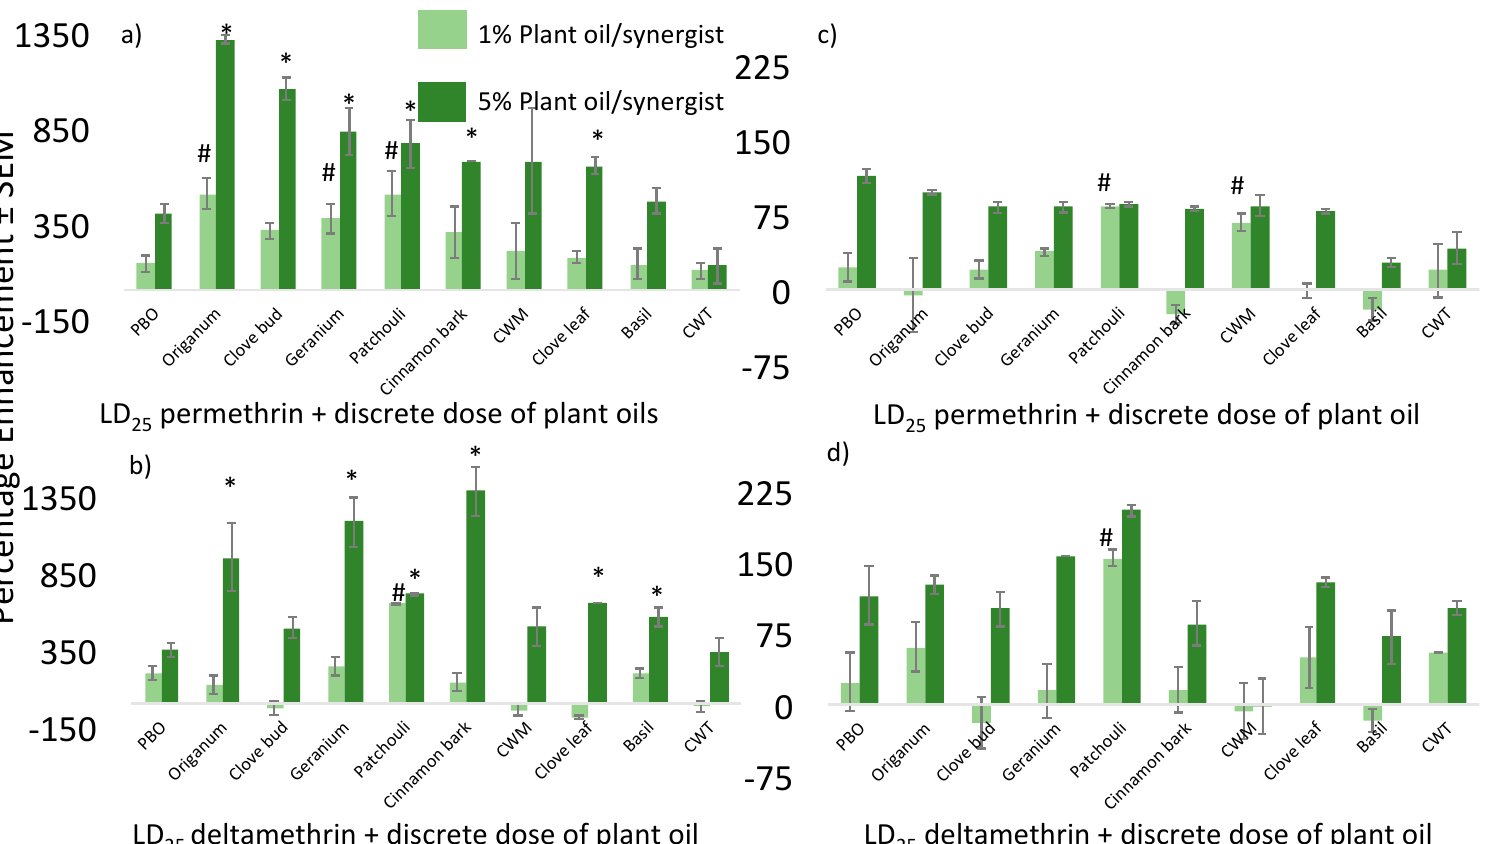
Figure 4. Percentage enhancement caused by plant essential oils applied in combination with select pyrethroids against two Anopheles gambiae strains. Percentage enhancement of ( a ) permethrin + plant essential oils against the G3 strain, ( b ) deltamethrin + plant essential oils against the G3 strain, ( c ) permethrin + plant essential oils against the AKRON strain, and ( d ) deltamethrin + plant essential oils against the AKRON strain. Asterisks denote significantly higher percentage enhancement caused by plant oils applied at the 5% level than PBO applied at the same concentration. Octothorpes (#) denote significantly higher percentage enhancement caused by plant oils applied at the 1% level than PBO applied at the same concentration.